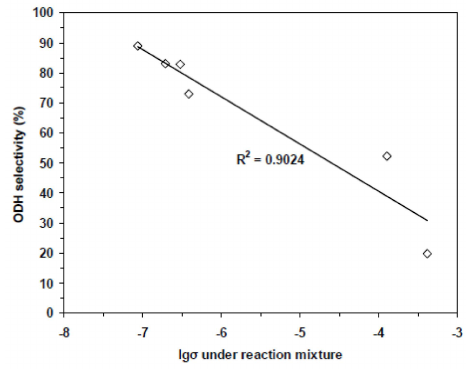
Figure 11. Variation of ethylene selectivity at ethane isoconversion at 350 ˝ C vs. electrical conductivity for NiO and Nb-doped NiO catalysts (From [67] copyright 2015, RSC Great